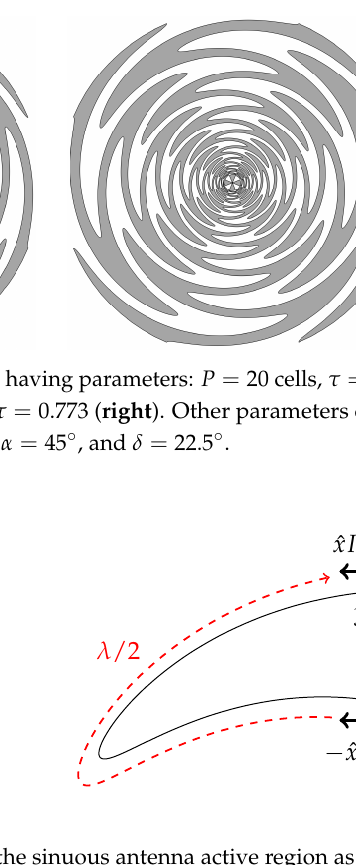
Figure 2. Illustration of the sinuous antenna active region as described in the original patent